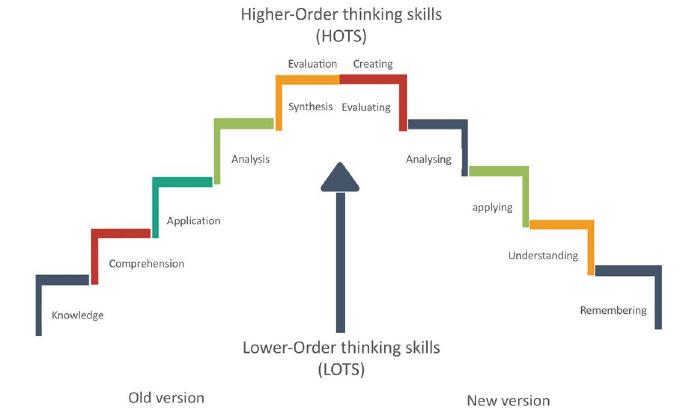
Figure 2. Bloom’s Taxonomy. Source: self-elaborated based on Krathwohl & Anderson